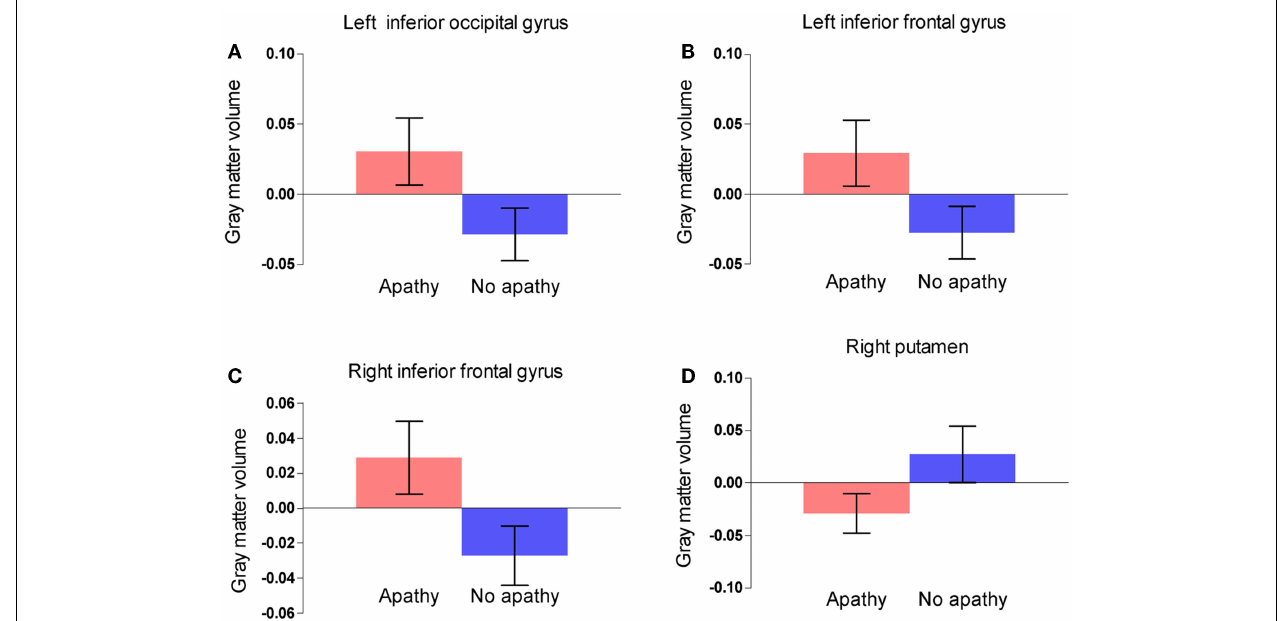
FIGURE 2 | Comparisons of gray matter volume within the clusters between two groups in the left inferior occipital gyrus (A), the right inferior frontal gyrus (B), the left inferior frontal gyrus (C), and the right putamen (D) . Error bars show 95% confidence intervals.